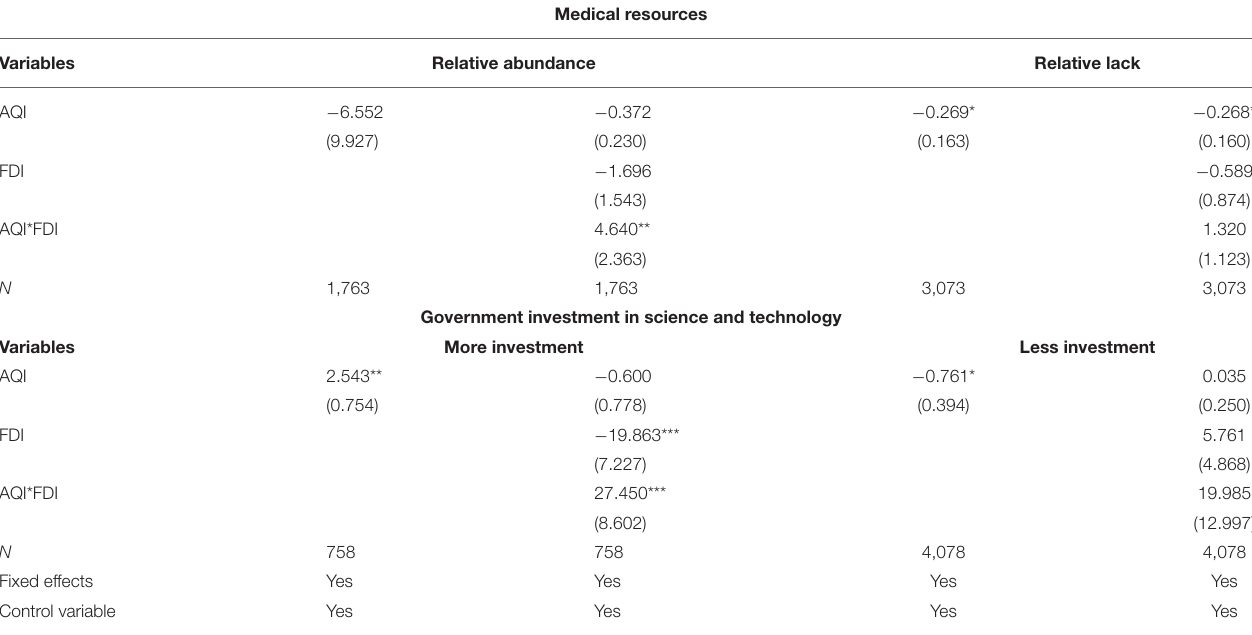
TABLE 7 | Heterogeneity based on medical resource and investment in science and technology.